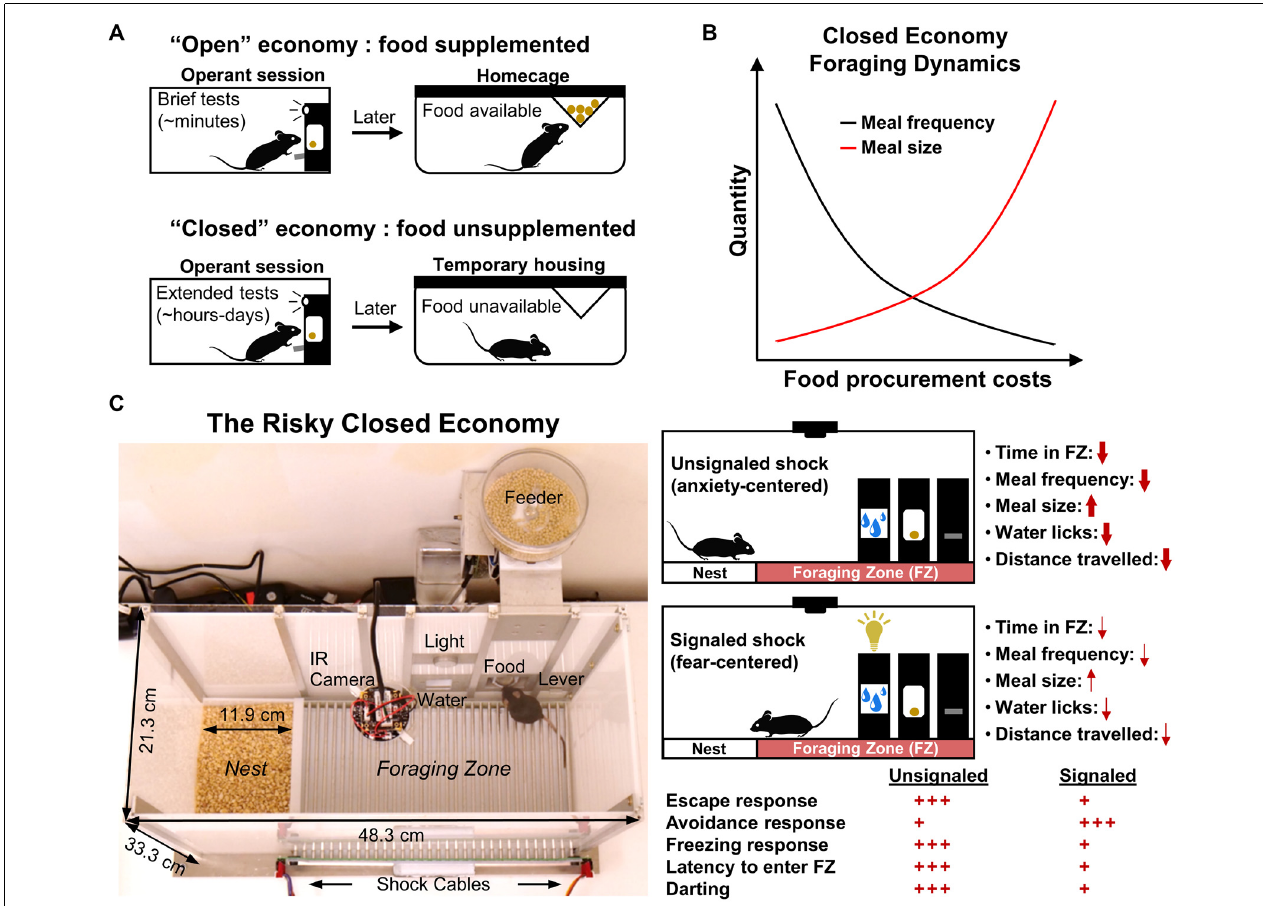
FIGURE 1 | Traditional closed economy concepts and The Risky Closed Economy (RCE). (A) In “closed economies,” food and/or water is not supplemented after testing; animals must earn all of their food and/or water during the testing session, reflecting naturalistic conditions. Closed economy experiments also typically utilize long testing periods. This contrasts with “open economies” where food is supplemented (e.g., food restriction) after brief tests. (B) The use of chained schedules of reinforcement in closed economy experiments (e.g., fixed ratio-continuous reinforcement) allows for discrete eating bouts (“meals”) and the number of pellets per eating bout (“meal size”) to be measured. Under optimal experimental parameters, closed economy animals characteristically decrease the frequency of meals and increase meal size in response to increasing food procurement costs. (C) In the RCE, pseudo-random footshock is integrated into a longitudinal closed economy framework as a means to model naturalistic risky foraging with predation threat. Use of an unsignaled (no cue) or signaled (cued) shock allows one to investigate the effects of diffuse, anxiety-evoking, or imminent, fear-evoking threat, respectively, on circadian and infradian behavior. Red arrow thickness and quantity of red plus signs represent the impact of shock condition on the listed behavioral variables under optimal experimental parameters (i.e., from rat studies mentioned in the text). Darting: sudden activity bursts exceeding 23.6